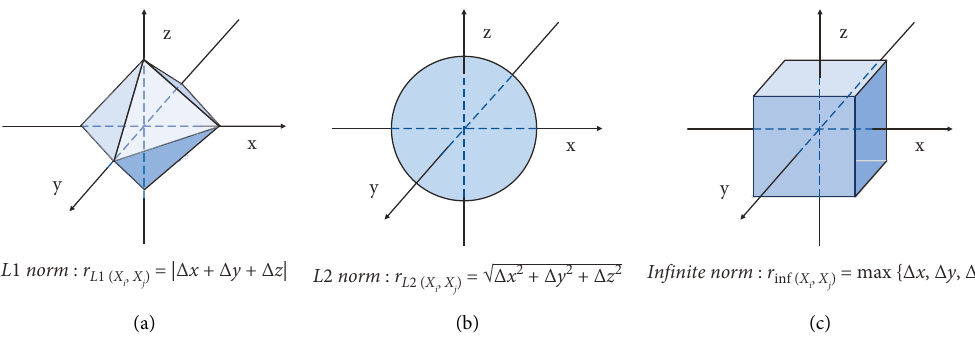
Figure 3: Search domain functions and geometric mappings of each paradigm: (a) the l1 norm metric; (b) the l2 norm metric; (c) the infinite norm